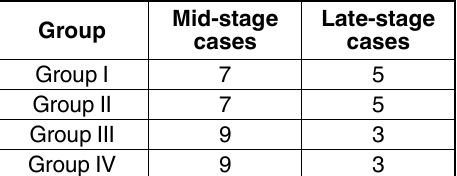
table 3. Group formation of mid-stage